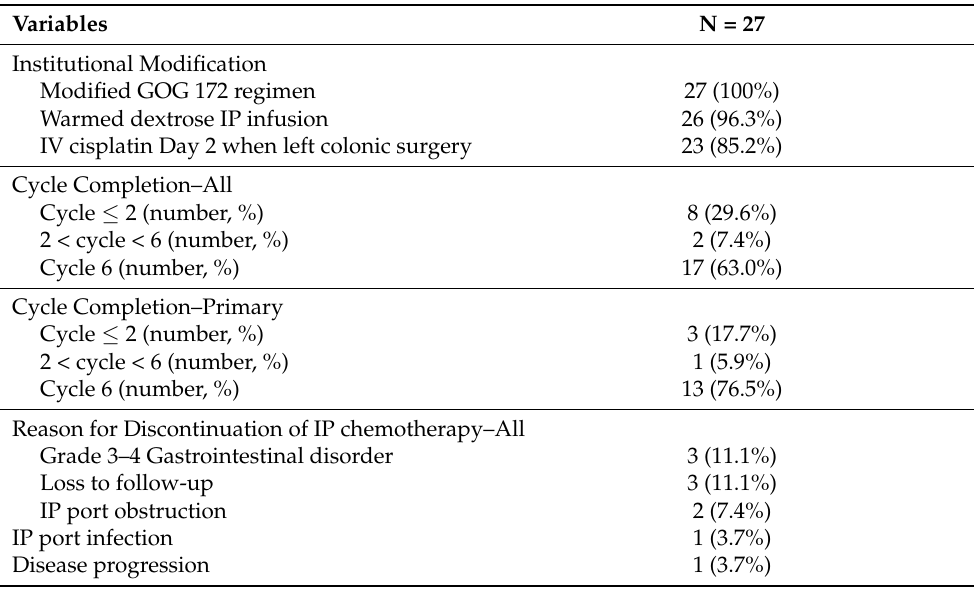
Table 2. Adherence of institutional modifications and cycle